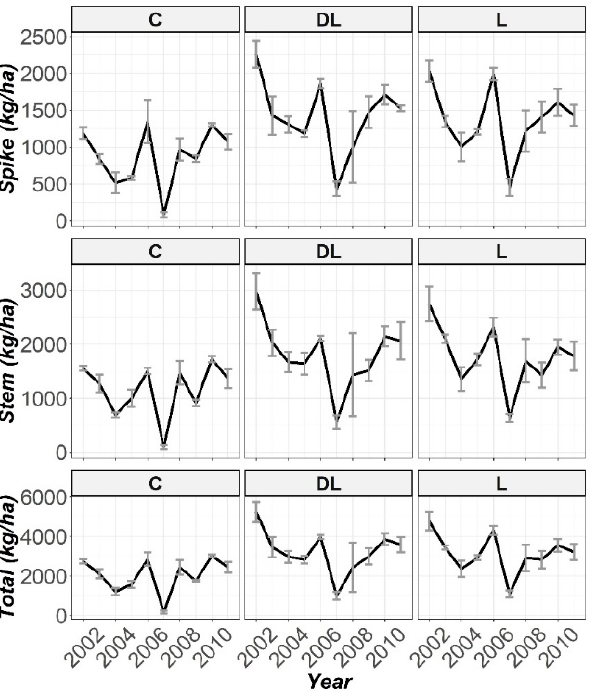
Figure 5. Temporal evolution of the spike, stem and total biomass throughout the ten years of biomass monitoring (2002–2011).